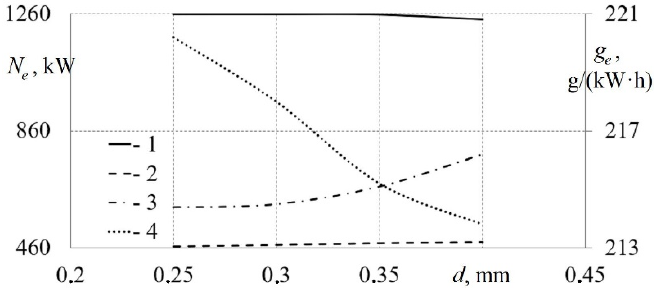
Figure 5. Dependences of power N e and specific fuel consumption g e on the diameter of holes d in the nozzle of a diesel injector at different modes: 1— N e = f ( d ) at the nominal engine mode; 2— N e = f ( d ) at idle; 3— g e = f ( d ) at nominal mode; 4— g e = f ( d ) at idle.